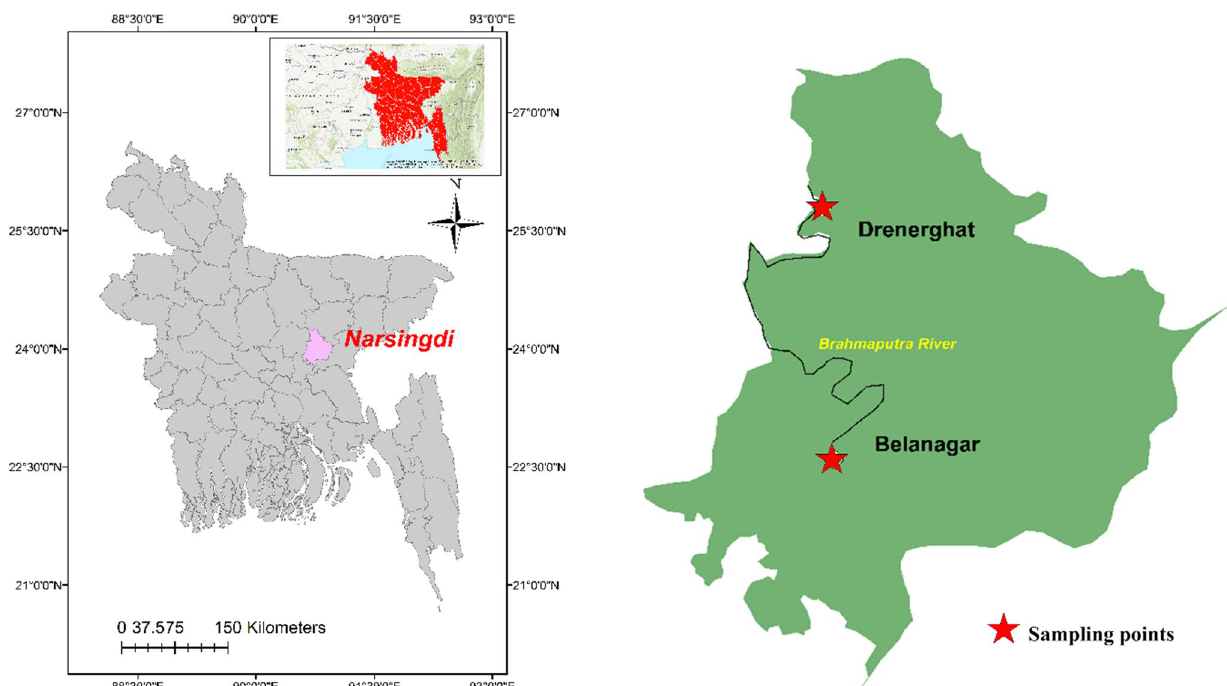
Fig. 1 Map showing sampling points of the Old Brahmaputra